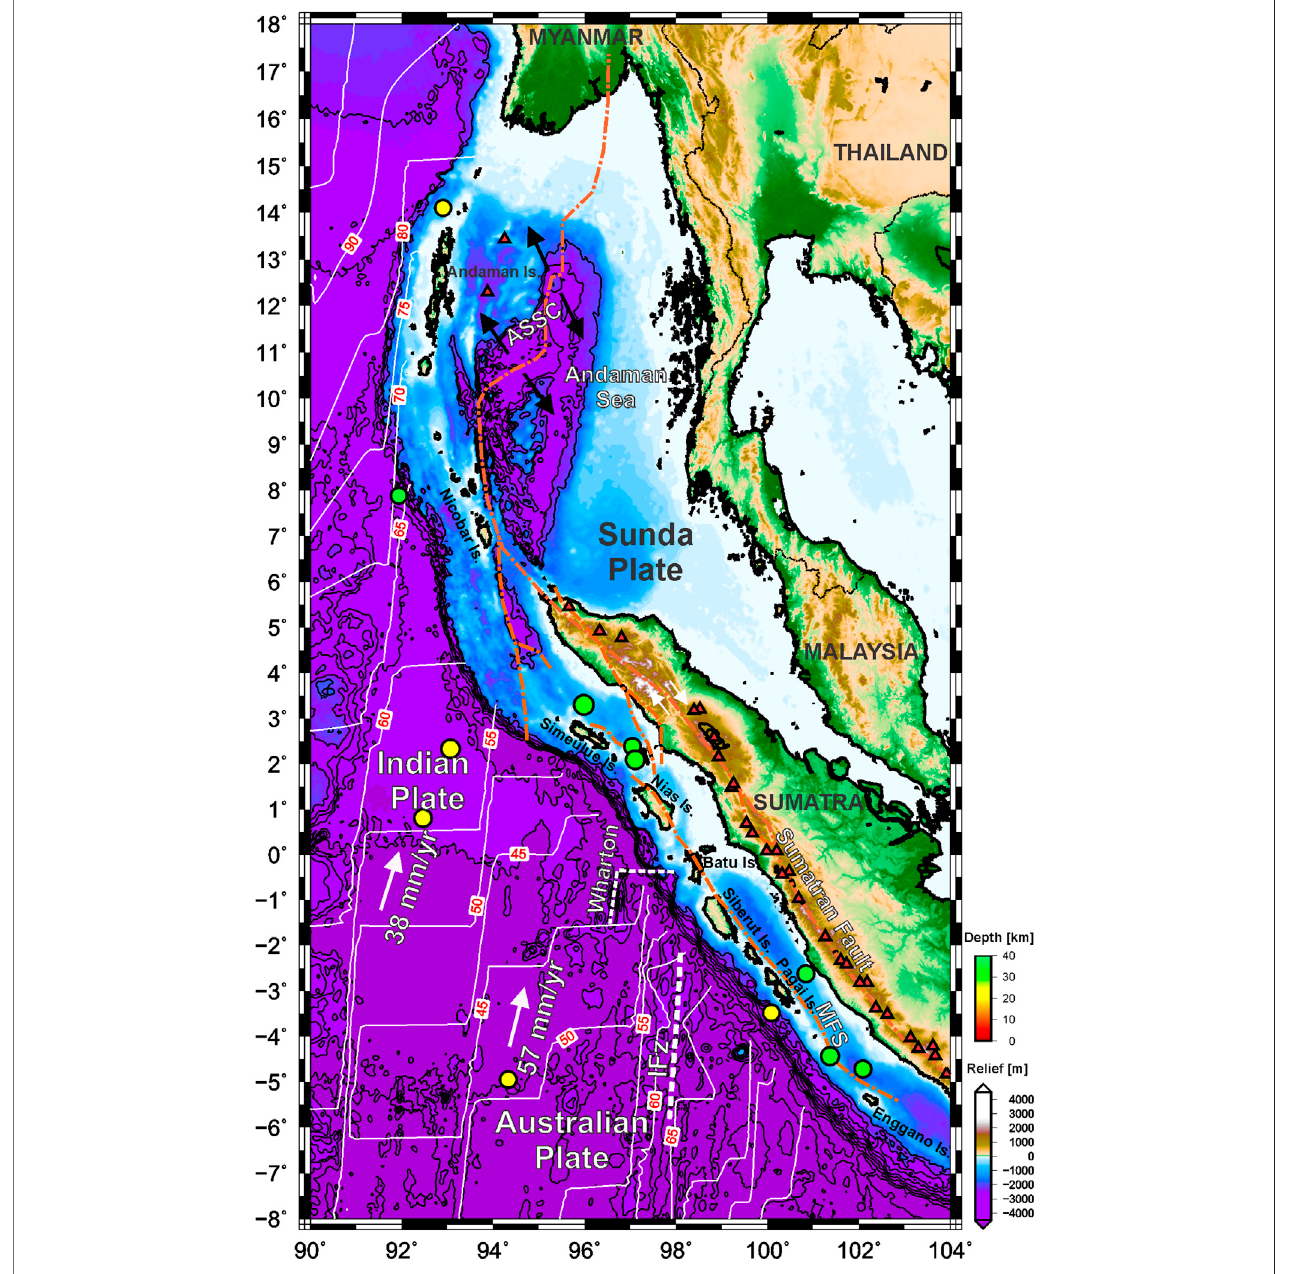
FIGURE 1 | Relief map of the Australian, Indian, and Sunda plates from ETOPO1 (Amante and Eakins, 2009) with main bathymetric features. Orange dot and dashed lineindicate themainfaults astheSumatran, Andaman,andMentawi fault system(MFS).Inthisregion, theIndian plate subductsobliquely beneath theEurasian plate along the Sunda subduction zone at an approximate rate convergence of 39 mm/yr Chlieh et al. (2008). White arrows in the Andaman Sea indicate the Andaman Sea Spreading Center (ASSC). Plates rate convergence is from Chlieh et al. (2008), plate ages (white solid lines) are from Müller et al. (2008), red triangles indicate the volcanic arc (Siebert and Simkin, 2002), and white dashed lines indicate the Wharton fossil ridge and the investigator fracture zone (Fz). Circles indicate earthquakes with Mw > 7.5 from 2000 A.D (from USGS); the upper color bar indicates earthquake depth.